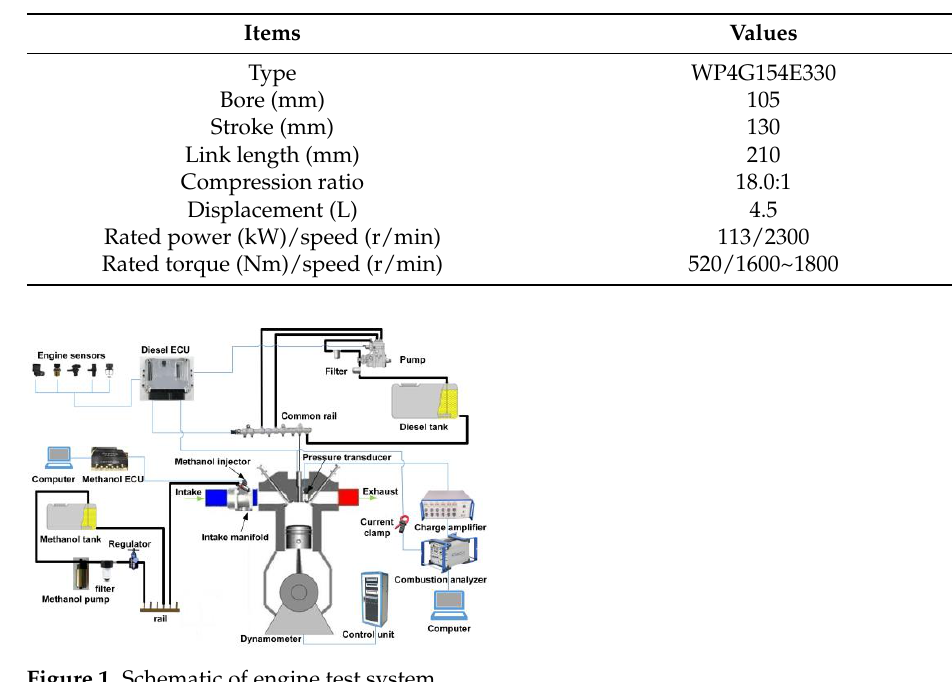
Table 1. Parameters of the test engine.